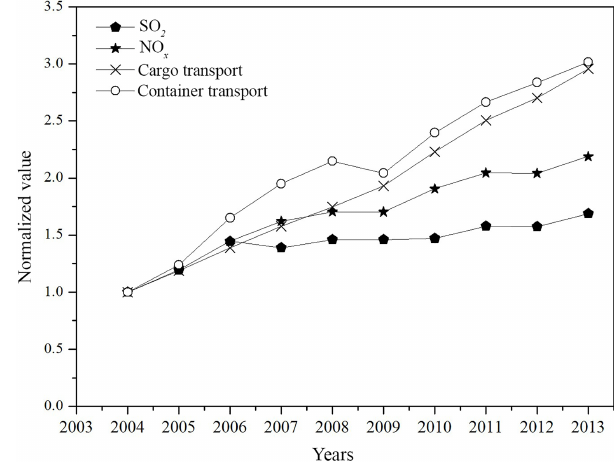
Figure 7. SO 2 and NO x emissions and their aggregated emissions from cargo and container transport from 2004 to